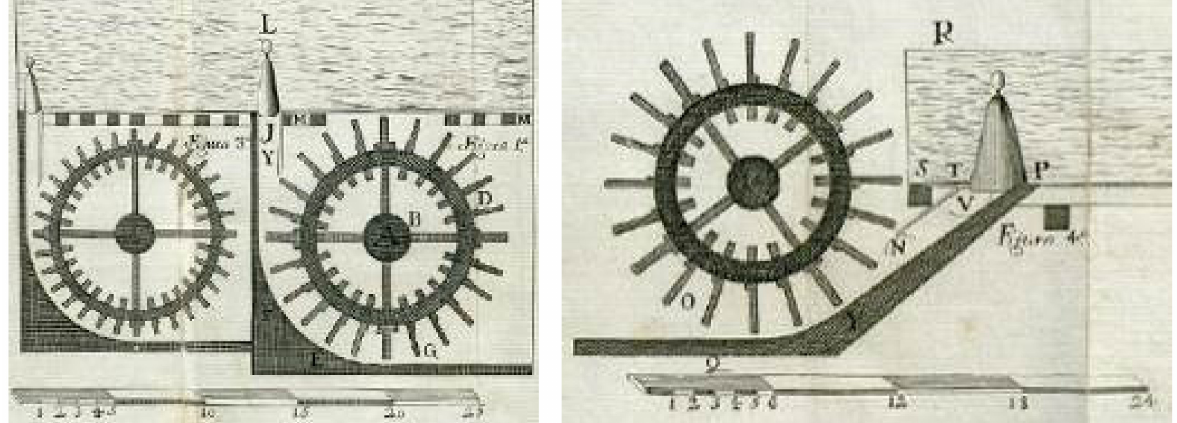
Figure 6. Gravitational and Vitruvian wheels according to Villa-Real